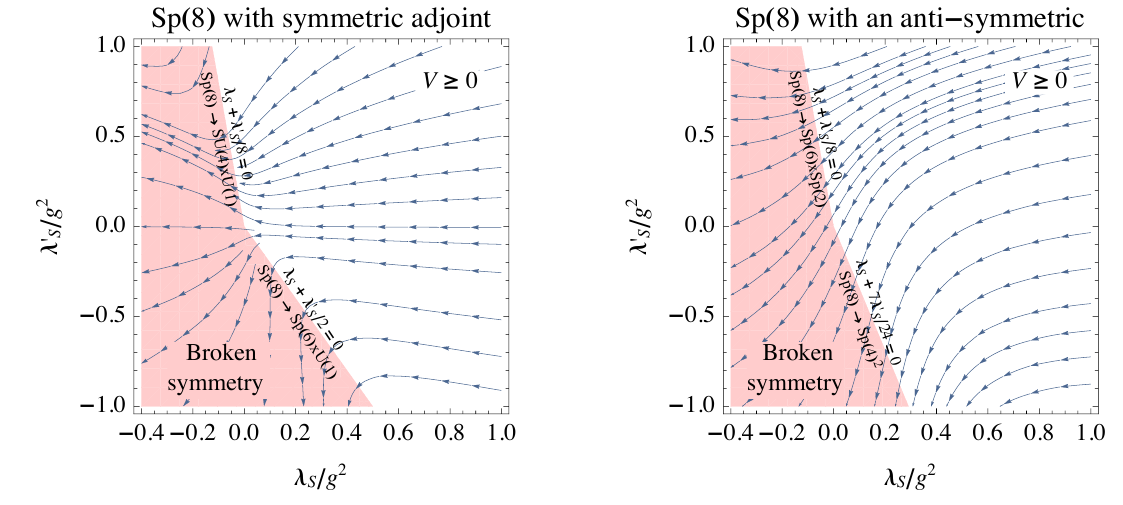
Figure 5 . Coleman-Weinberg symmetry-breaking patterns for a Sp( N ) gauge theory. The RGE (cid:13)ow towards low energy of its quartics (cid:21) S and (cid:21) 0 can enter both instability conditions, leading to S the two di(cid:11)erent breaking patterns discussed in the